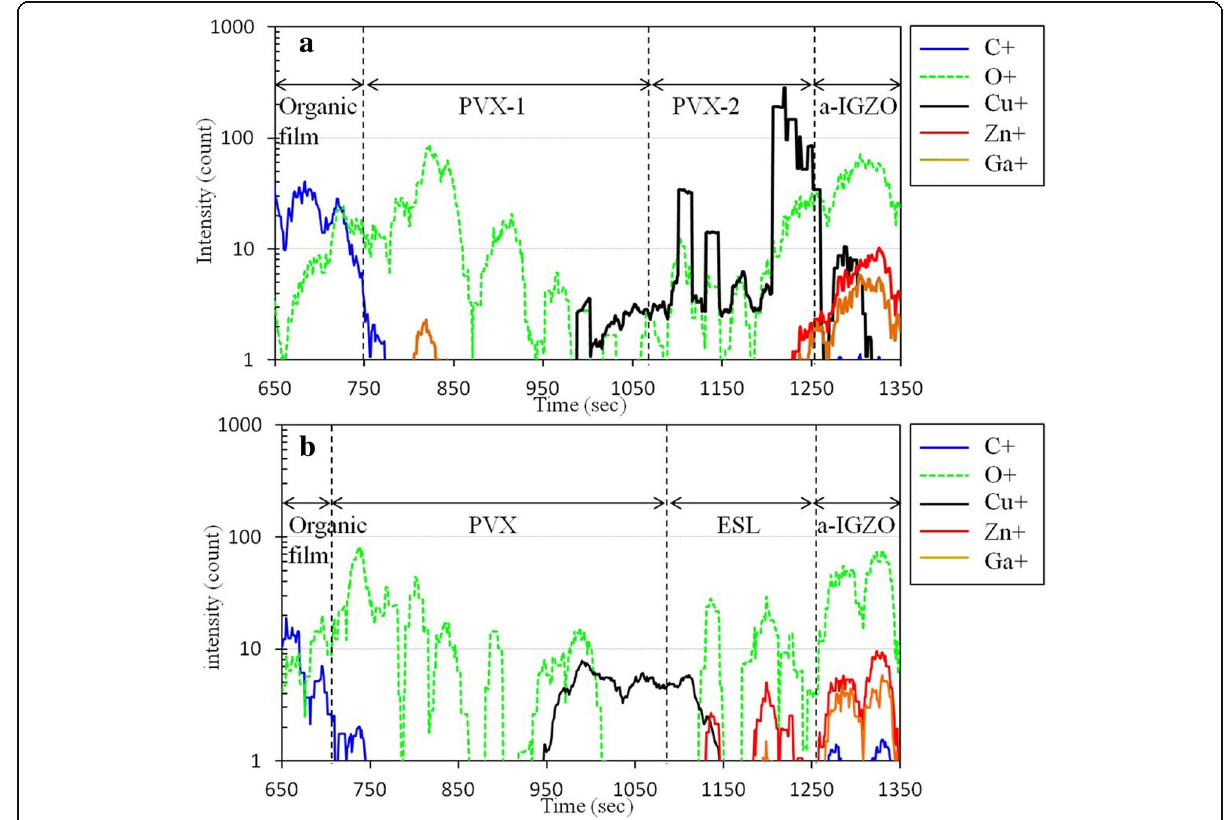
Fig. 5 TOF-SIMS analysis of the channel regions of a-IGZO TFTs fabricated via a the BCE and b the CL-ES